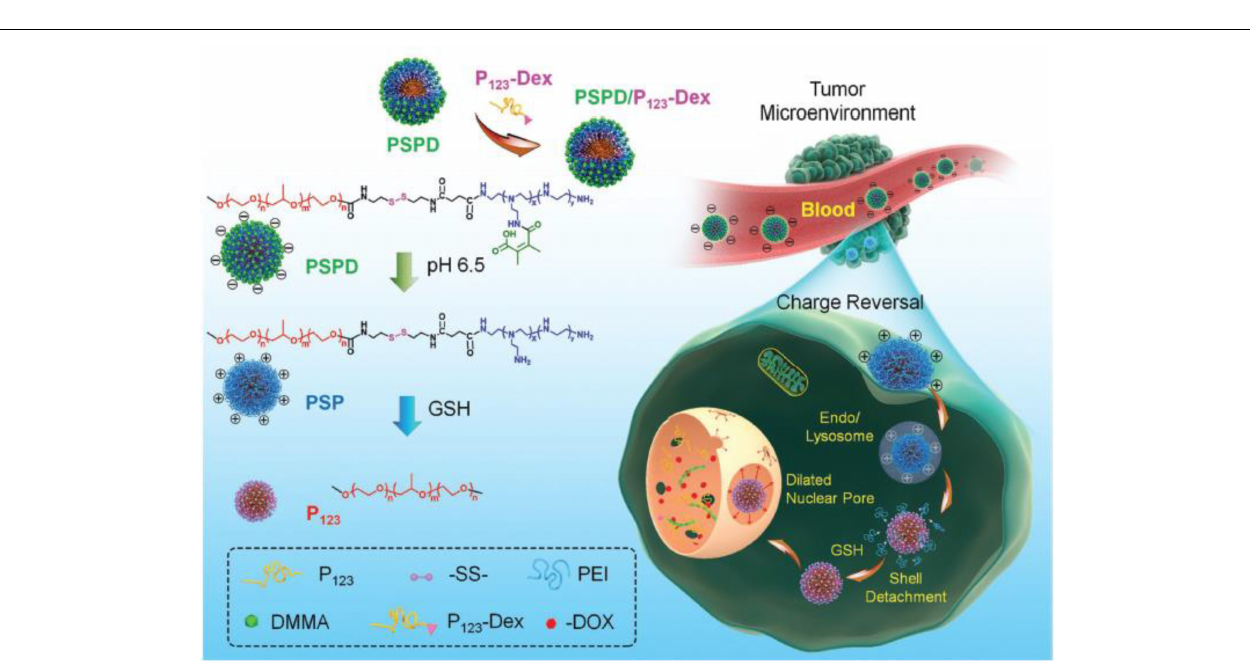
FIGURE 6 | Schematic illustration of a size reducible core-corona nanostructure that was self-assembled by two unimers of conjugated Pluronic P 123 to DMMA-PEI (PSPD) via disulfide bond and dexamethasone modified Pluronic P 123 (P 123 -Dex). The core-corona nanostructure efficiently delivered DOX into the nucleus of tumor cells through exploiting acidic pH and intracellular redox potential, as well as the ability of dexamethasone to target and dilate nuclear pores (reproduced with permission from Wang et al. (2017). Copyright 2017 John Wiley and Sons).